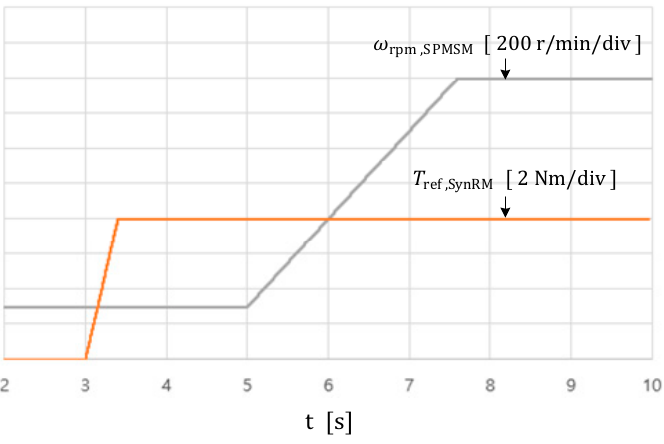
Figure 7. Experimental sequence.